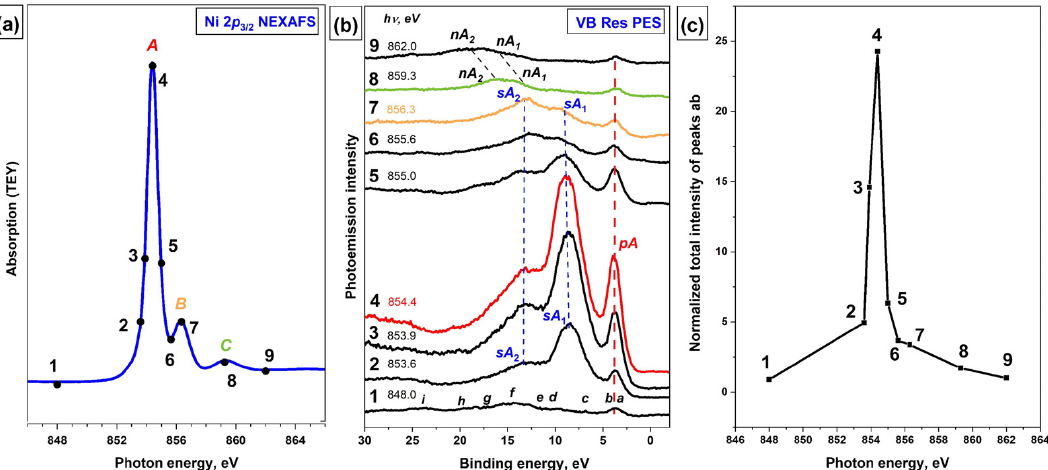
Figure 3. ( a ) Ni 2p 3/2 NEXAFS spectrum, the photon energies used to excite the VB PE spectra are marked with numbered dots; ( b ) a series of resonant VB PE spectra of [Ni(Salen)]; and ( c ) the total intensity of ab band depending on the energy of exciting photons in the vicinity of the Ni 2p 3/2 edge ( h ν = 848 – 862 eV) of the [Ni(Salen)] complex. The total intensity of the PE band ab at different photon energies was normalized to its intensity at h ν = 848 eV (non-resonant excitation). pA —electron band due to participator-Auger decay; sA 1 and sA 2 —low- and high-energy electron bands due to spectator Auger decay; nA 1 and nA 2 —electron bands due to normal Auger decay of Ni 2p 3/2 − 1 3d 9 excitations. The next, less intense absorption band B at h ν = 856.3 eV (point 7) is attributed to Ni 2p 3/2 electron transitions to empty π * -MO, which has a strong hybridized character with the contributions from valence Ni 3d , O 2p , and N 2p AOs, and reflects the presence of